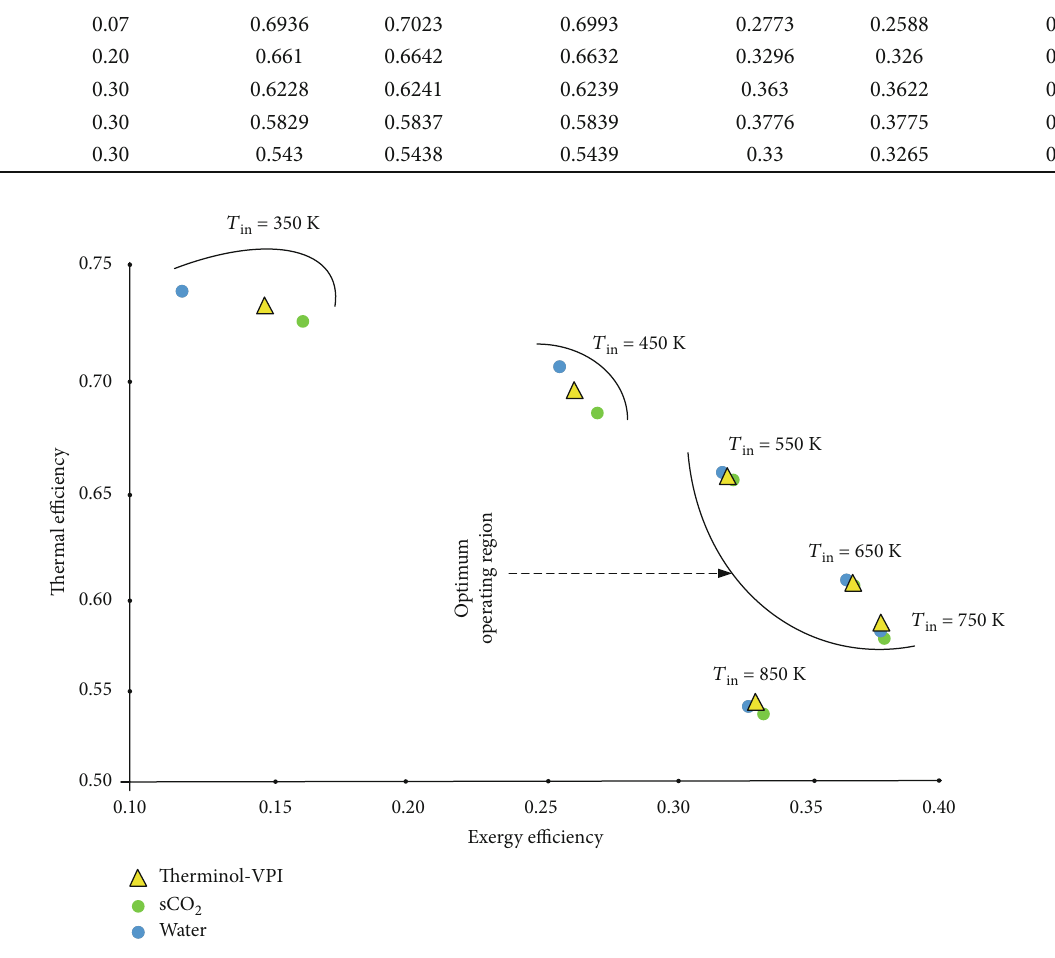
Figure 7: E ffi ciency map of PDSC for the three investigated fl uids at various inlet temperature